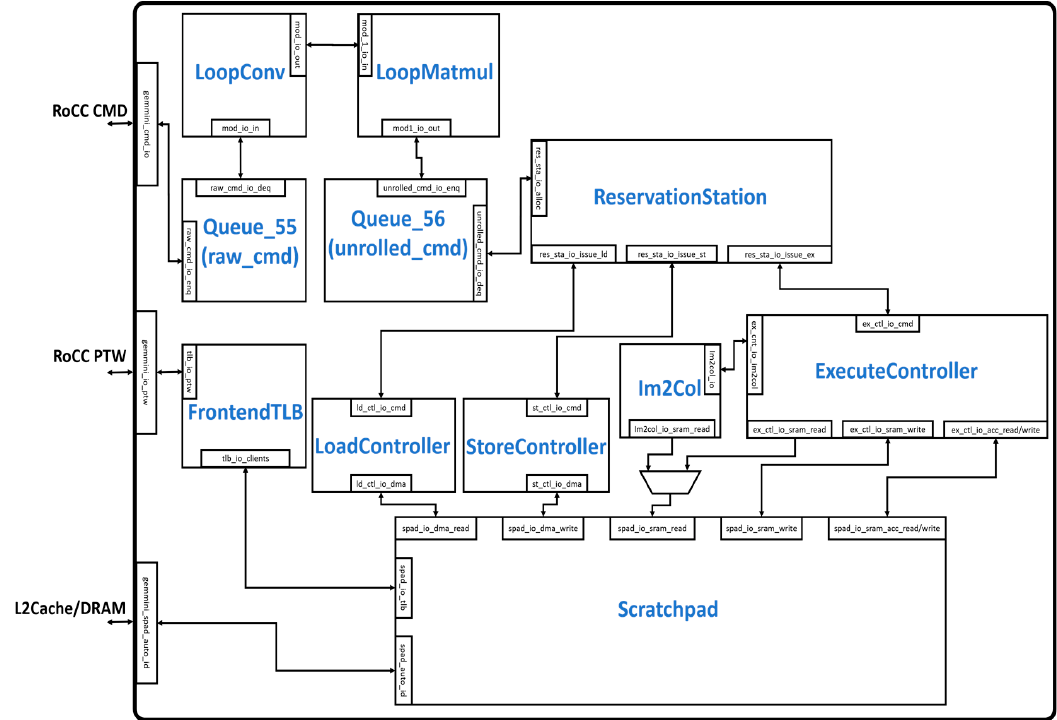
Figure 2. Modules in the Gemmini hardware architecture.